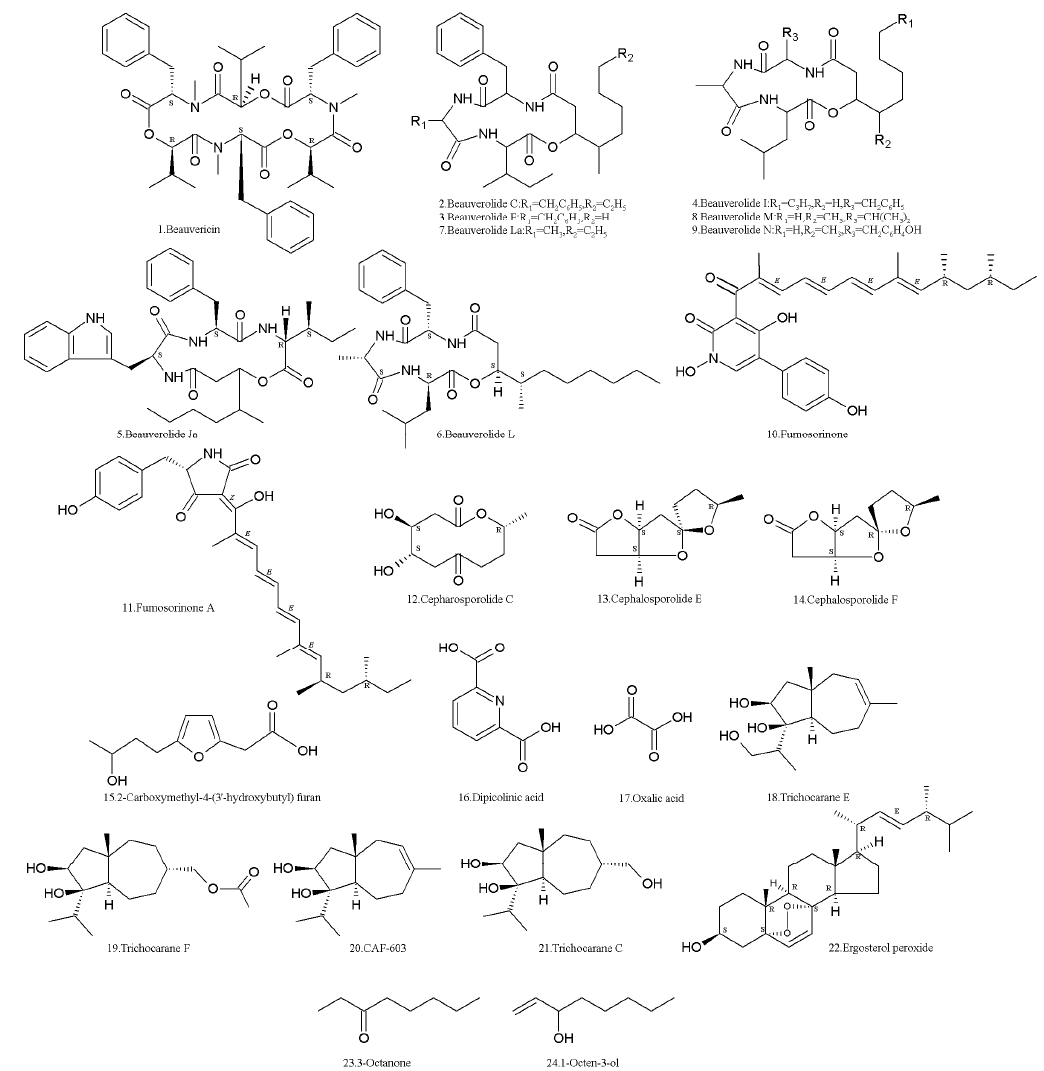
Figure 1. Structures of secondary metabolites (SMs) isolated from Isaria fumosorosea.